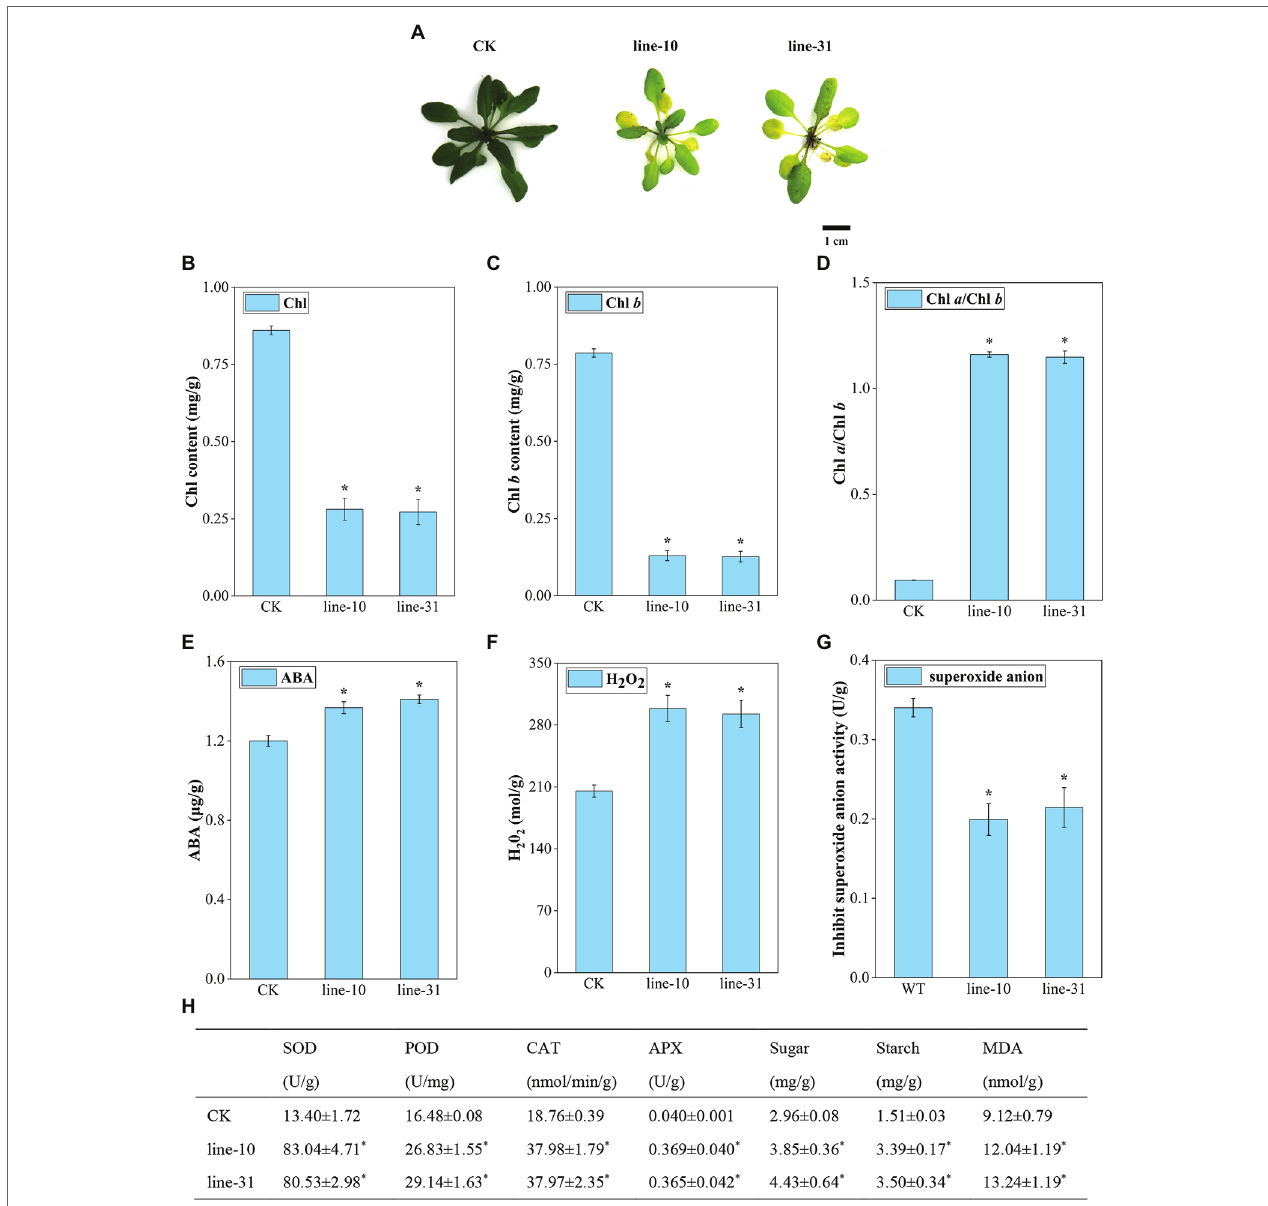
FIGURE 6 | Morphological and physiological assessment of ZjNOL -overexpressing lines. (A) Photographs of transgenic plants compared with control. (B) Chlorophyll (Chl) contents. (C) Chlorophyll b (Chl b ) content. (D) Chlorophyll a /Chlorophyll b (Chl a /Chl b ) ratio. (E) ABA content. (F) H 2 O 2 content. (G) Inhibit superoxide anion activity. (H) Physiological changes of enzyme activities (SOD, POD, CAT, and APX) and carbohydrate content (sugar, starch, and MDA). Results are means of three replicates ± SDs. Asterisks indicate significant differences at p ≤ 0.05 based on Student t